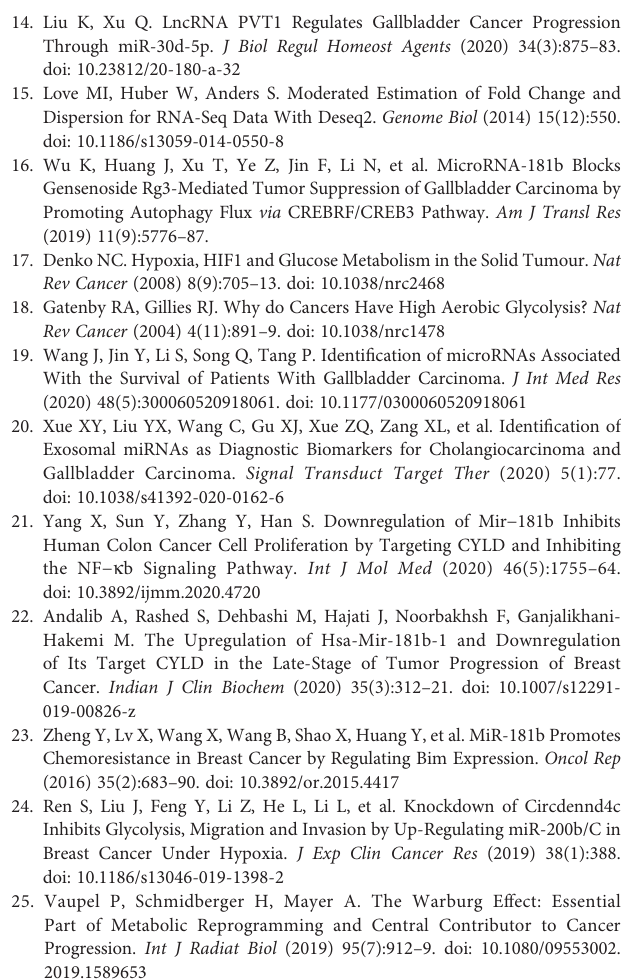
Supplementary Figure 1 | KEGG analysis of protein targets of DEGs. KEGG analysis of protein targets of miR-126-3p, miR-451a, miR-4487, miR-140-3p, miR- 494, miR-10b-5p, miR-26b-5p, miR-335-5p. Supplementary Figure 2 | The expression of PDHX in HIBEpiC cells under hypoxic condition. (A, B) HIBEpiC cells were treated with hypoxia or hypoxia. Western blot was performed to measure the expression of PDHX in HIBEpiC